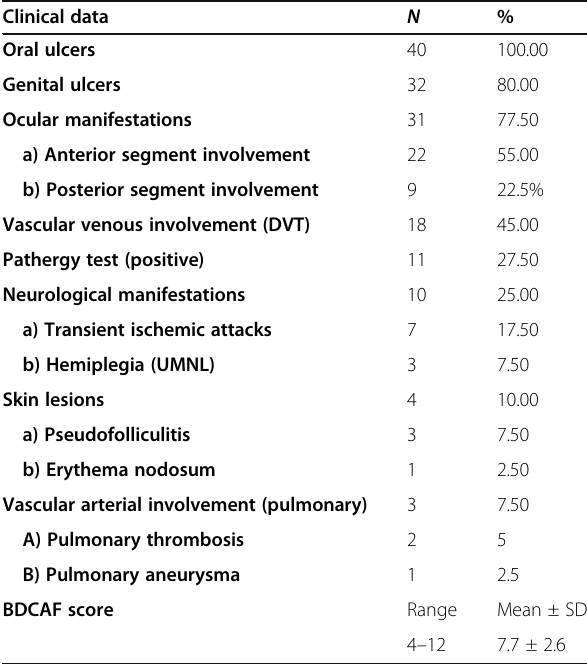
Table 1 Cumulative clinical data among the included Behçet ’ s patients and disease activity score ( N = 40) Clinical